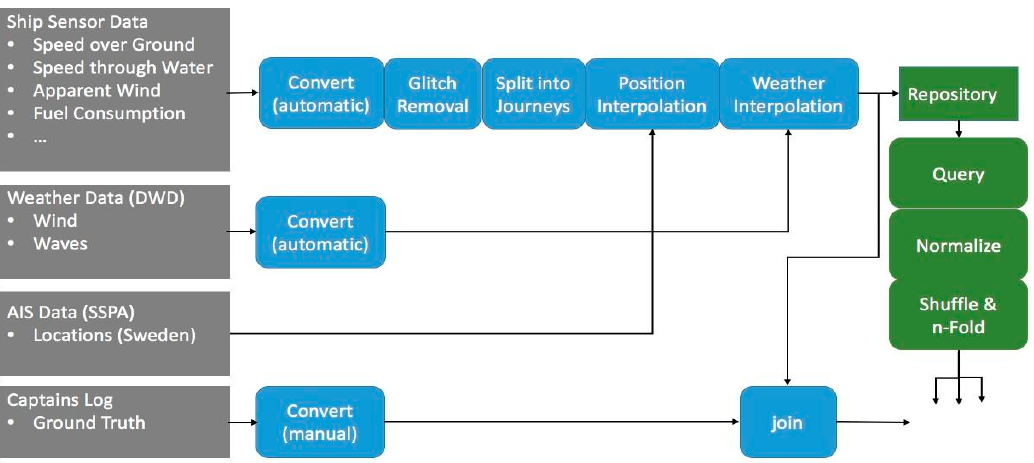
Figure 3. Data pipeline to provide an overview in data pre-processing.